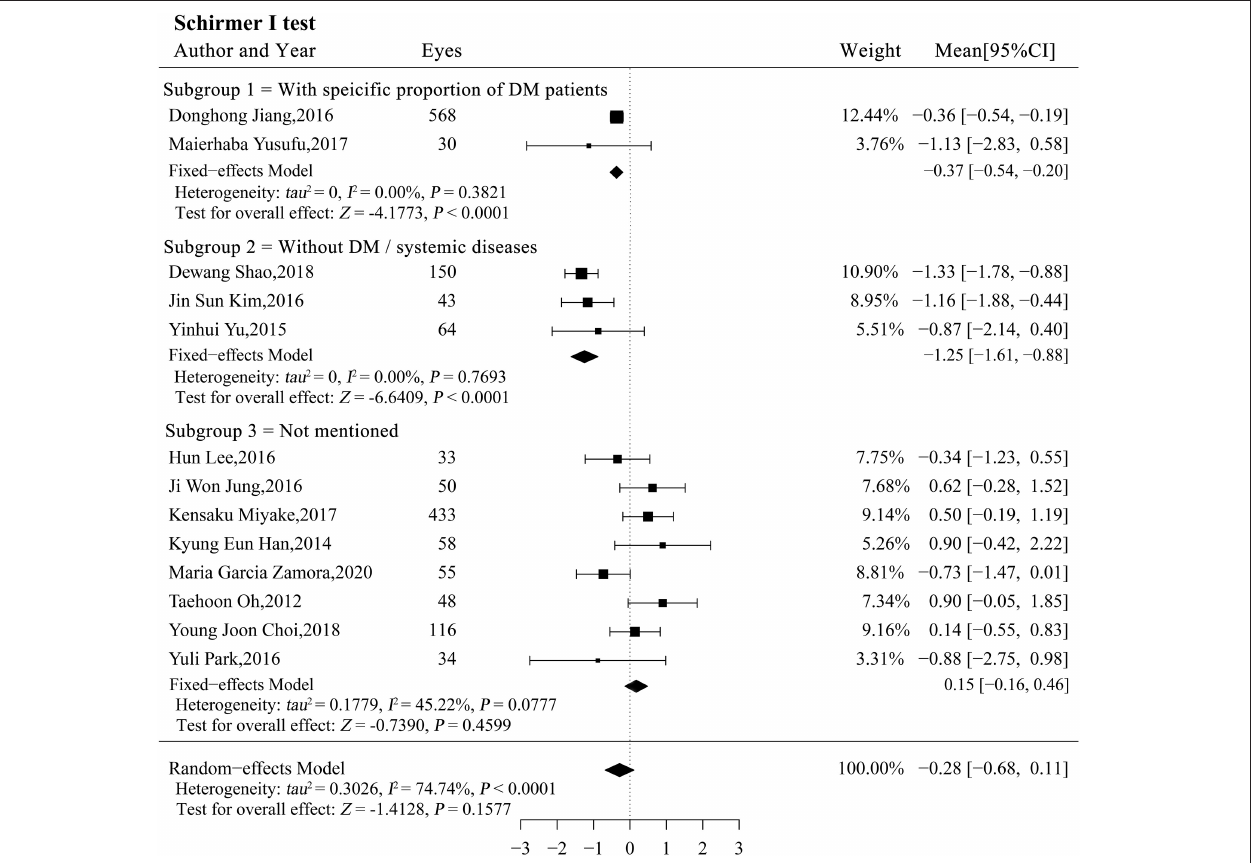
FIGURE 5 | Forest plots of change in the Schirmer I test after phacoemulsification cataract surgery. CI, confidence interval; DM, diabetes mellitus.